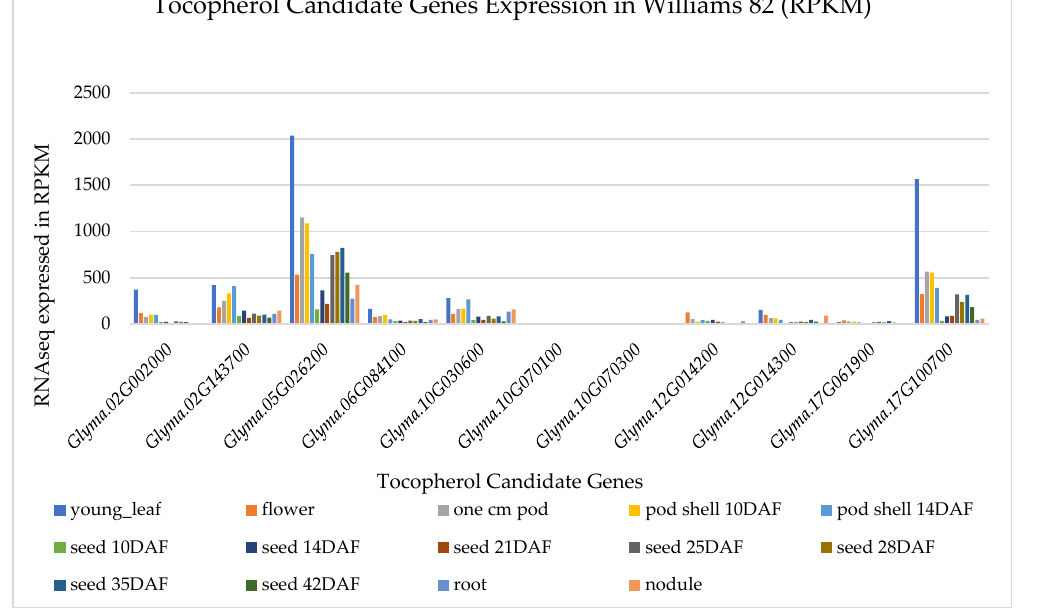
Figure 3. ( A ). Tissue specific expression of the identified tocopherol candidate genes. ( B ). Expression pattern of the 11 tocopherol candidate genes located within tocopherol QTL in Williams 82 (RPKM) were retrieved from publicly available RNA-seq data from Soybase database (http://www.soybase.org/soyseq; accessed on 3 April 2022).